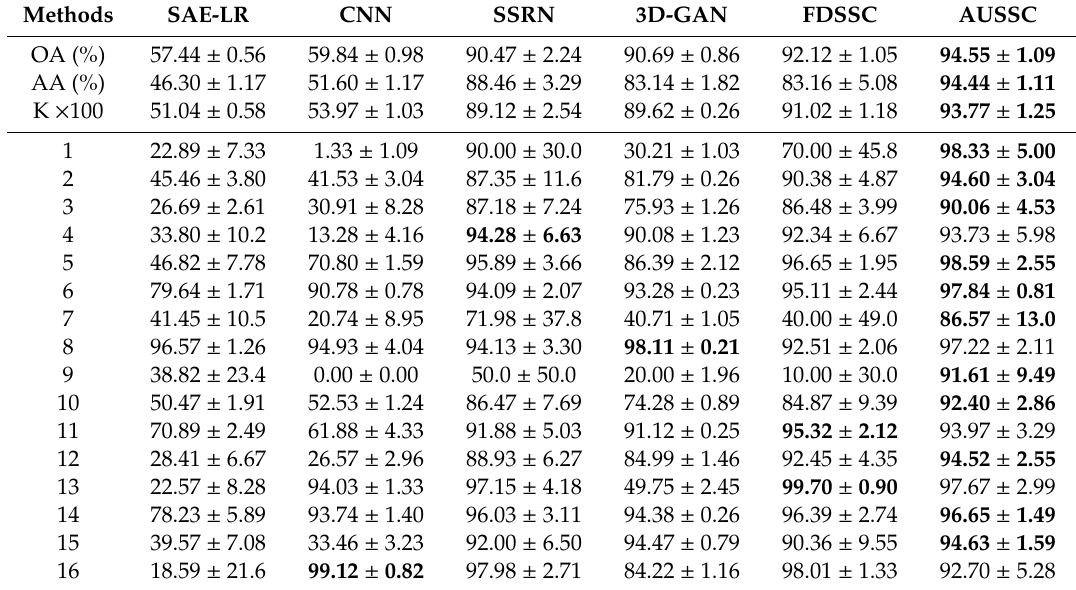
Table 4. Overall accuracy (OA), average accuracy (AA), kappa coe ffi cient (K), and accuracy for each HSI category in the Indiana Pines (IP) data set. Data are given as mean ± standard deviation.